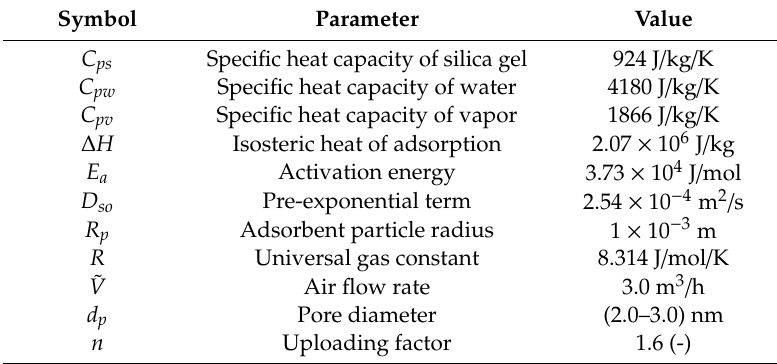
Table 1. Parameters used for the analysis of the